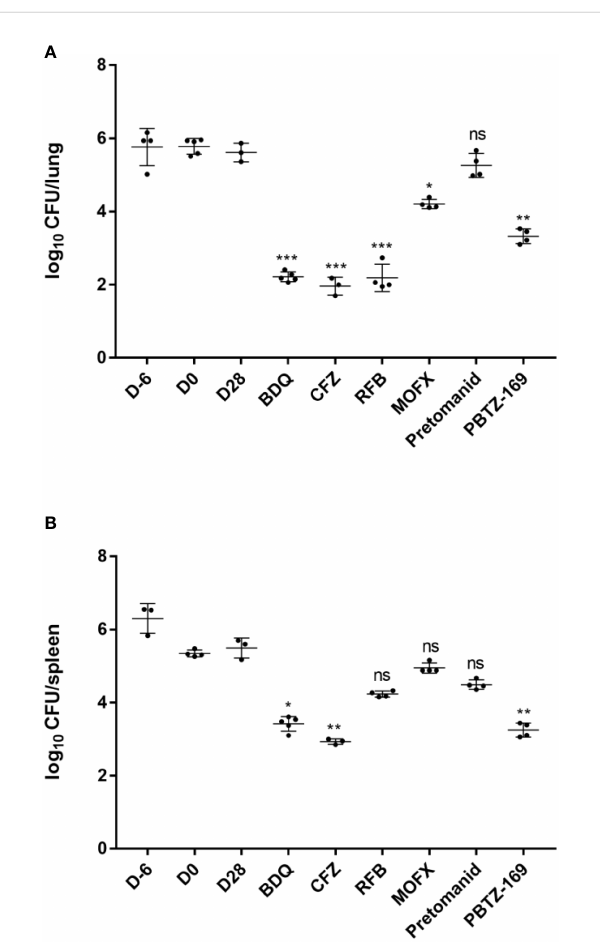
FIGURE 4 Mean number (log 10 ) of CFU per lung (A) and spleen (B) in various groups of mice infected with M. chelonae . Six mice failed to infect due to operational reasons(one each from CFZ, RFB, MOFX and PBTZ169 group, and two from CMC). Two mice died during the treatment period (one each from CFZ and pretomanid group). *P <0.05; **P <0.01; ***P